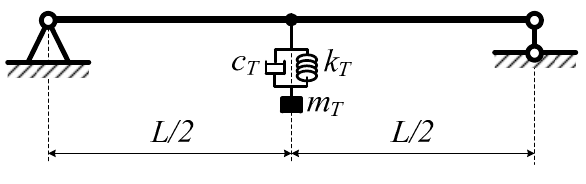
Figure 4. Beam with one TMD.